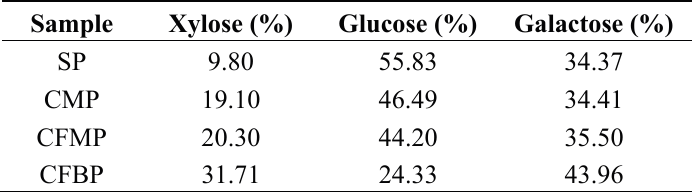
Table 2. Monosaccharide compositions and molar percentages (%) of SP, CMP, CFMP and